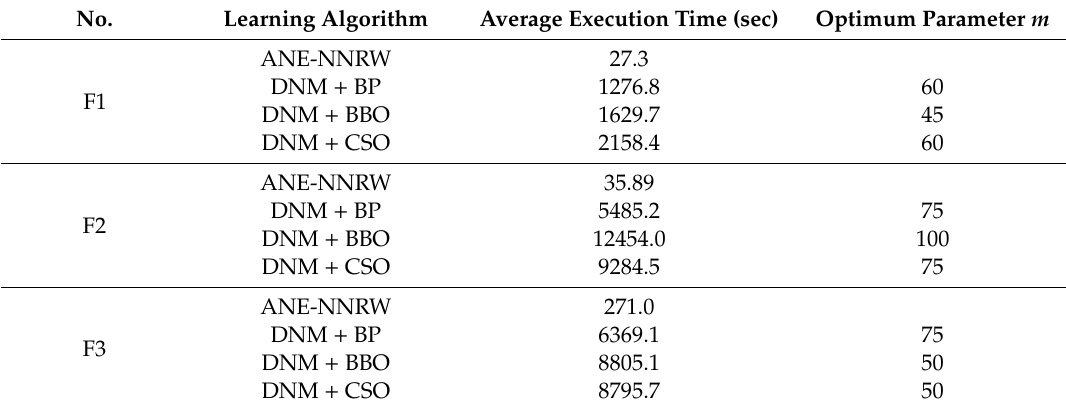
Table 15. Average execution time and optimum parameter of each learning